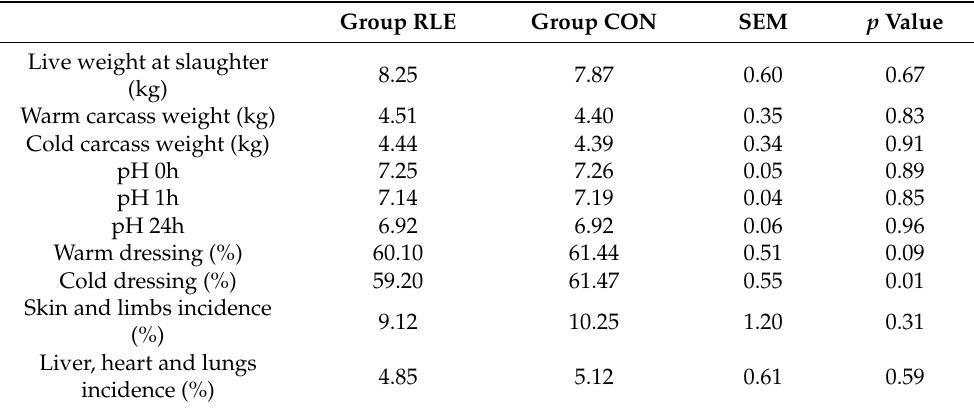
Table 3. Effect of including RLE in the diet on kids slaughtering performances in Group RLE (RLE treated group); Group CON